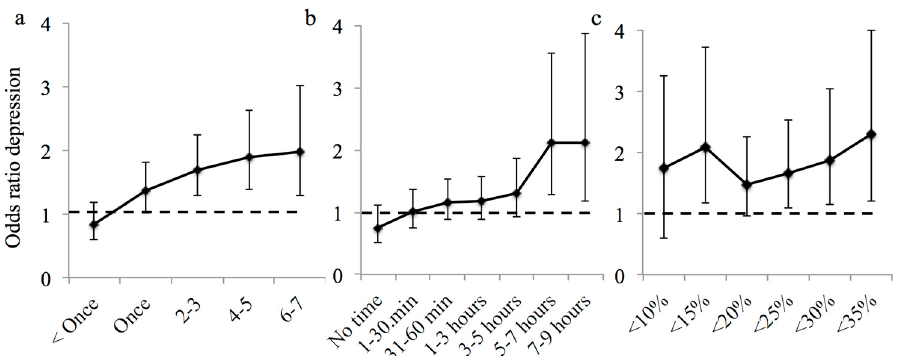
Figure 2. Dose-response graphs showing the adjusted odds ratio from logistic regression of depression for ( a ) incrementally increasing frequency of visits of ten minutes or more to a private green space; ( b ) total duration of time spent in private green space in the past week and ( c ) percentage neighbourhood vegetation cover. The 95% confidence intervals are shown. An odds ratio above one indicates that an individual is more likely to have depression where the nature dose is not met.